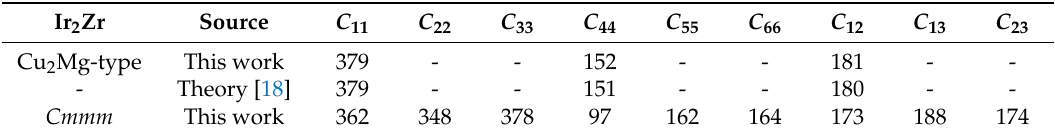
Table 1. Calculated single elastic constants C ij (in GPa) of Cu 2 Mg-type and Cmmm phases for Ir 2 Zr intermetallic compound.